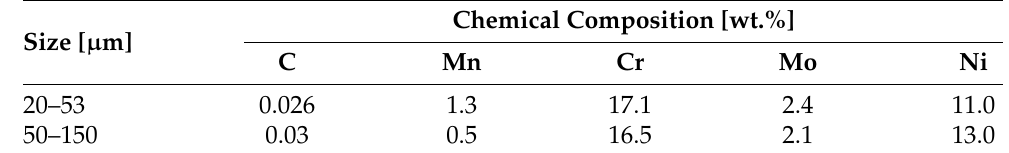
Table 2. Chemical composition of AISI 316L austenitic stainless steel powders, provided by material supplier.